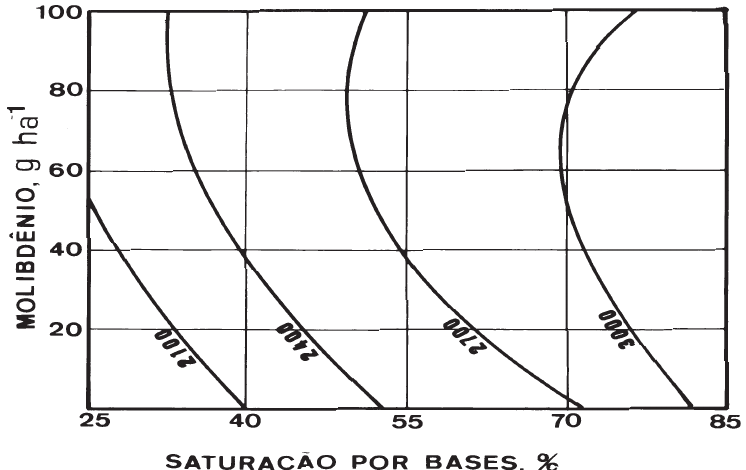
Figura 2. Isoquantas de produção de grãos de soja (IAC 11) em função de níveis de calagem e doses de